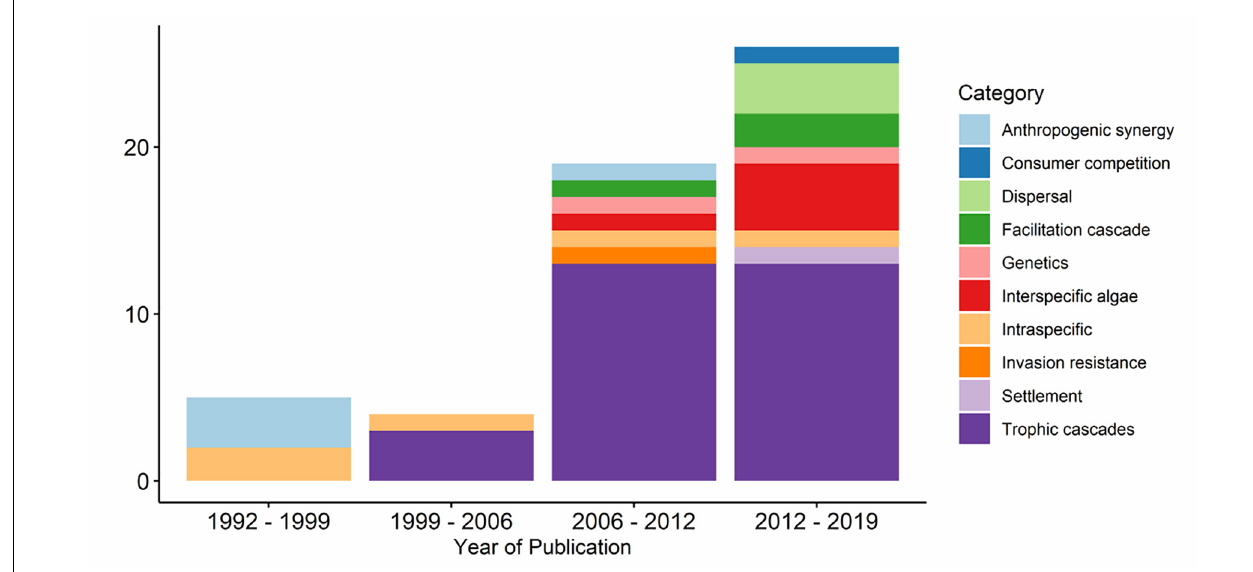
FIGURE 1 | Number of publications identified in the literature search by year and by category.